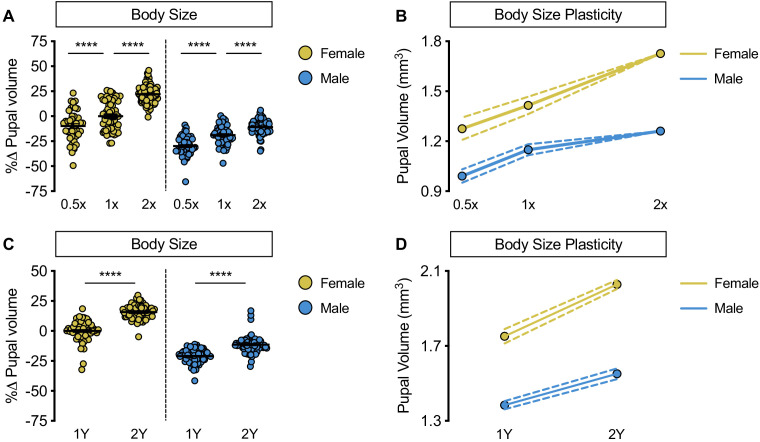
Increased female body size plasticity in a protein-rich diet.(A) Pupal volume was significantly higher in w1118 males and females cultured on a widely used diet (1X) compared with larvae raised on a reduced-nutrient diet (0.5X) (p<0.0001 and p=0.0006, respectively; two-way ANOVA followed by Tukey HSD test). The magnitude of this increase in pupal volume was the same in both sexes (sex:diet interaction p=0.7048; two-way ANOVA followed by Tukey HSD test). Pupal volume was significantly higher in w1118 males and females raised on a nutrient-rich diet (2X) compared with larvae cultured on 1X (p<0.0001 for both; two-way ANOVA followed by Tukey HSD test); however, the magnitude of the increase in body size was significantly larger in females than in males (sex:diet interaction p<0.0001; two-way ANOVA followed by Tukey HSD test). (B) Reaction norms for pupal volume in w1118 larvae raised on diets of varying quantity (0.5X, 1X, 2X), plotted using data presented in panel A. n = 43–100 pupae. (C) Pupal volume was significantly higher in both males and females cultured on a yeast-rich medium (2Y) compared with larvae raised on a diet containing half the quantity of yeast (1Y) (p<0.0001 for both sexes; two-way ANOVA followed by Tukey HSD test); however, the magnitude of the nutrient-dependent increase in pupal volume was larger in females than in males (sex:diet interaction p=0.0001; two-way ANOVA followed by Tukey HSD test). (D) Reaction norms for pupal volume in response to changes in dietary yeast in w1118 females and males, plotted using the data presented in panel C. n = 62–80 pupae. For body size plasticity graphs, filled circles indicate mean body size, and dashed lines indicate 95% confidence interval. **** indicates p<0.0001; error bars indicate SEM.